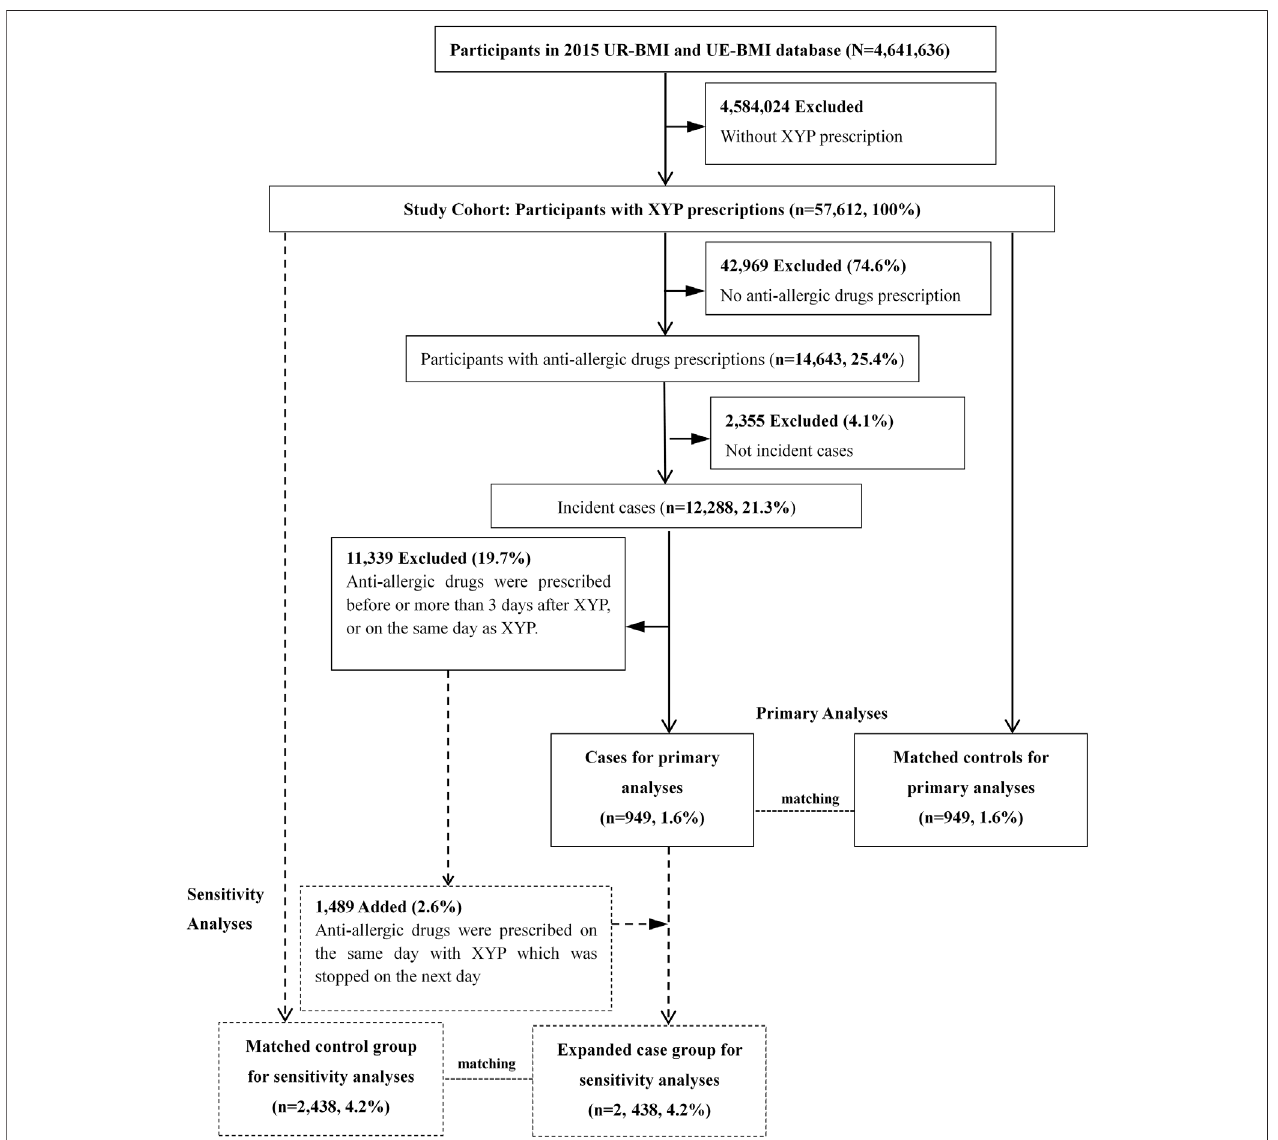
FIGURE 1 | Flowchart of patient